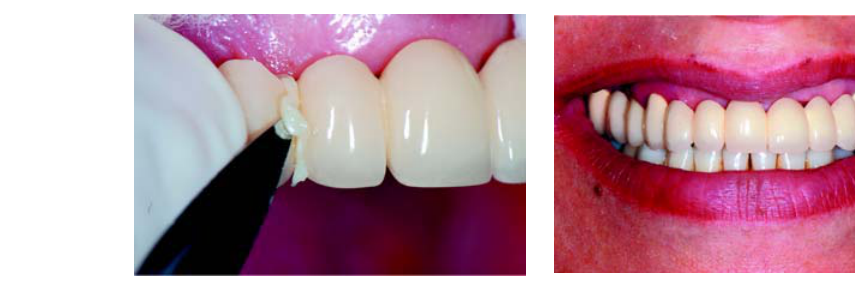
FIGURE 12- Fragment in position pressed against the prosthesis and composite excess removal